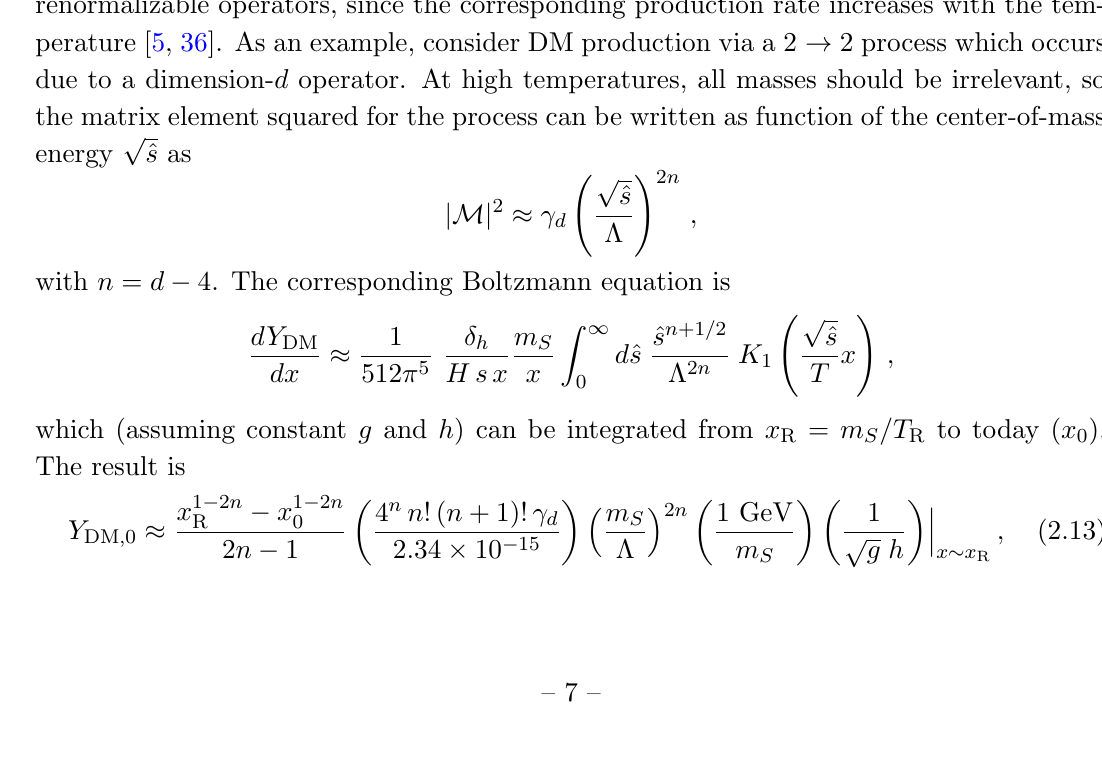
2 m for (cid:31) =m S;T (cid:17)